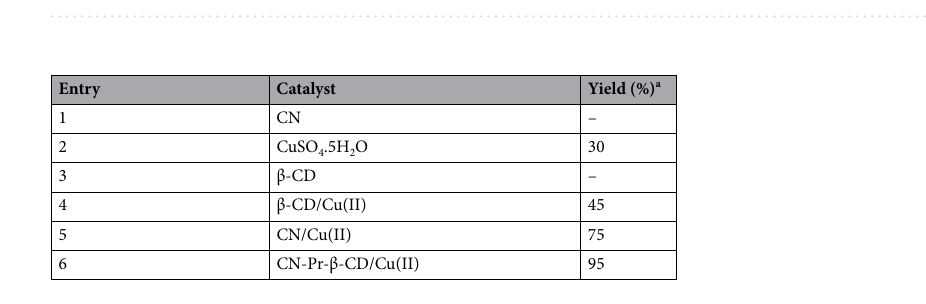
Table 2. Comparison of the catalytic performance of CN-Pr-β-CD/Cu(II) with other catalysts in synthesis of amide through the oxidative amidation of benzylic alcohols. Reaction condition: benzylamine